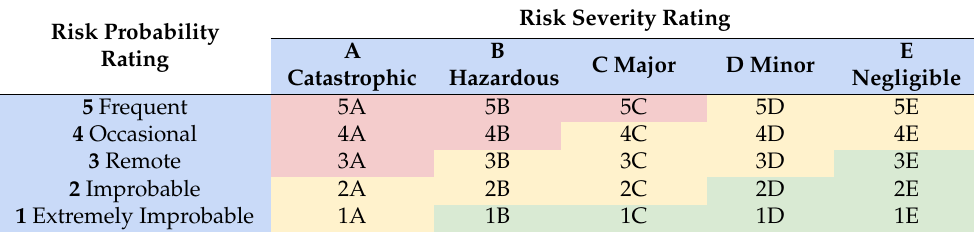
Table 2. Risk management planning